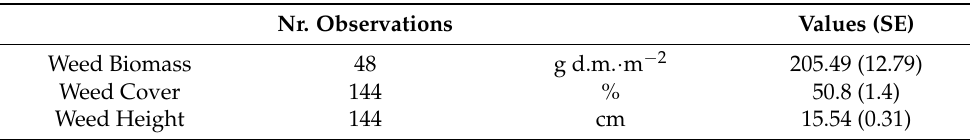
Table 6. Parameter mean values recorded before the mowing treatments of the second trial (standard error).